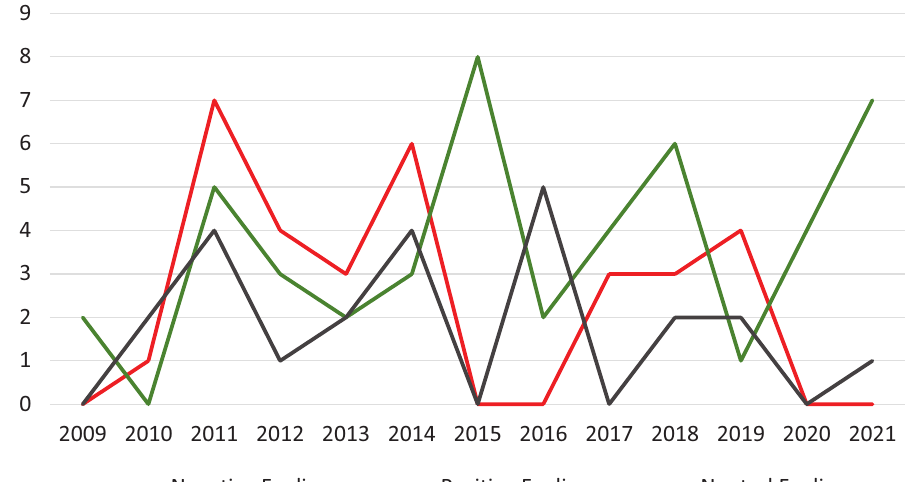
Figure 6. Digital media negative, positive, and neutral positions timeline